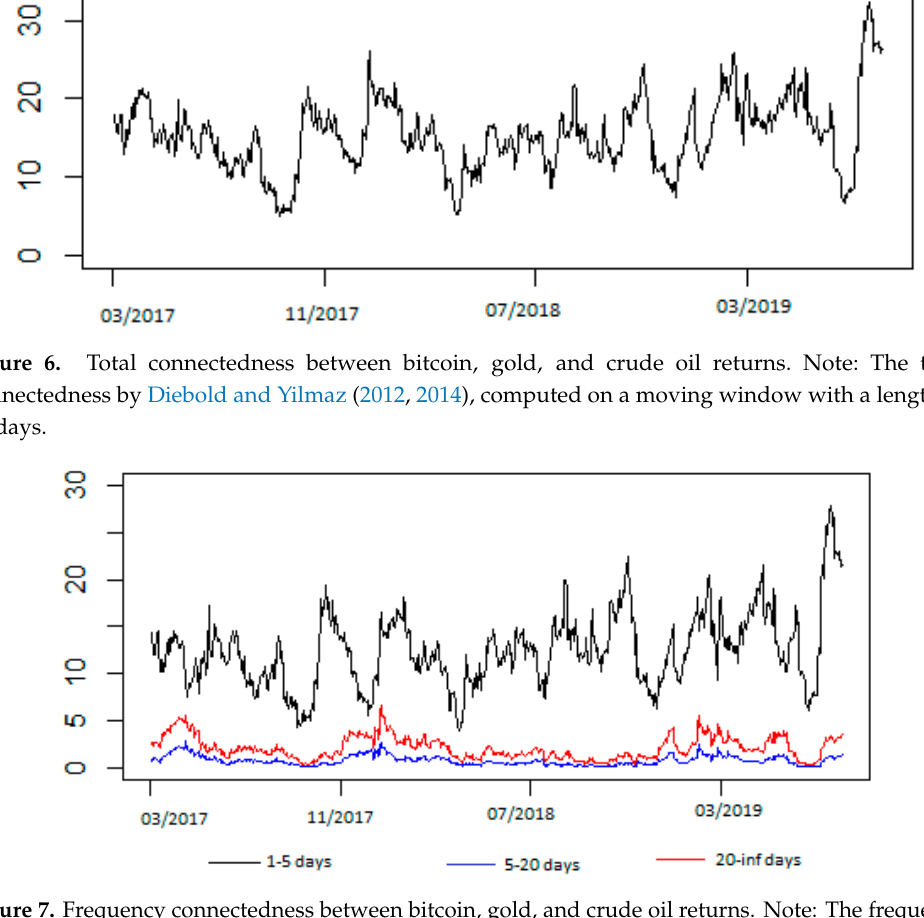
Figure 7. Frequency connectedness between bitcoin, gold, and crude oil returns. Note: The frequency connectedness by Baruník and K ř ehlík (2018) with [1; 5] days in black, [5; 20] days in blue, and [20; 300] days in red. All lines through the frequency bands sum to the total connectedness.